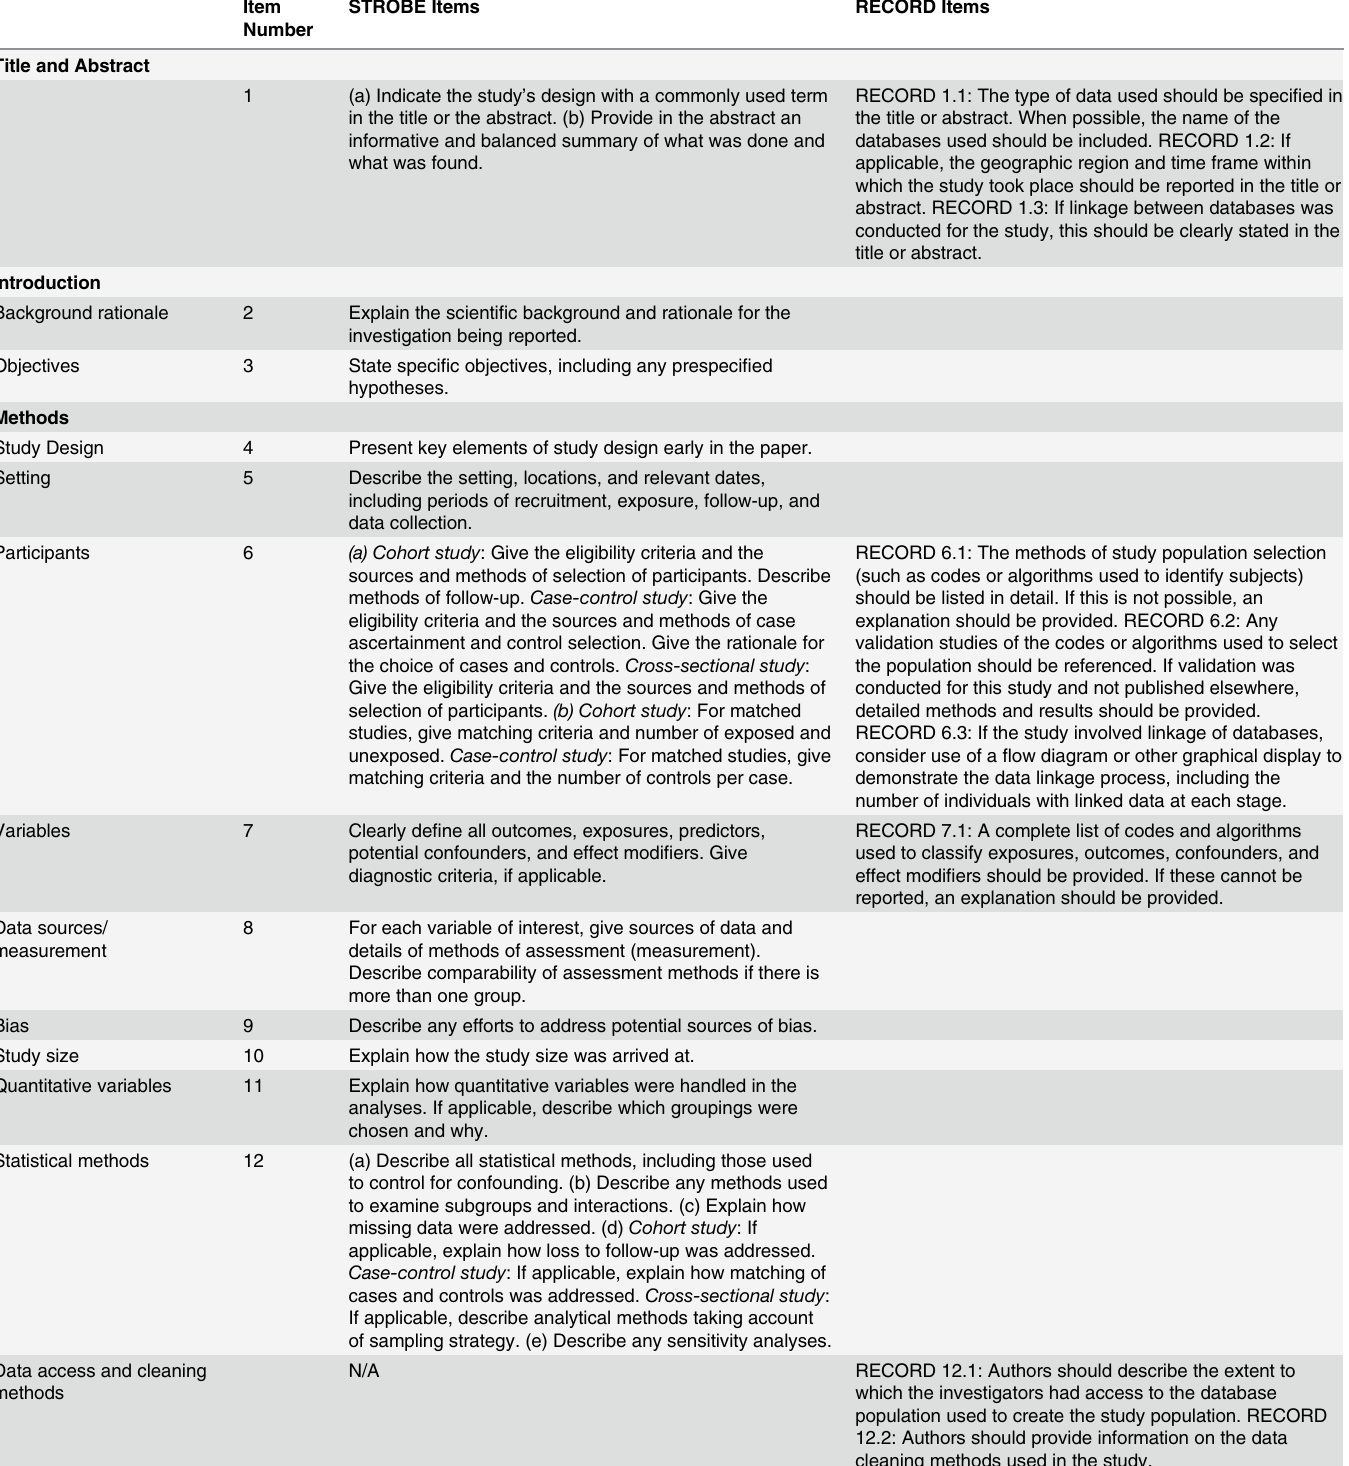
Table 1. The RECORD statement: Checklist of items, extended from the STROBE statement, that should be reported in observational studies using routinely collected health data. Item